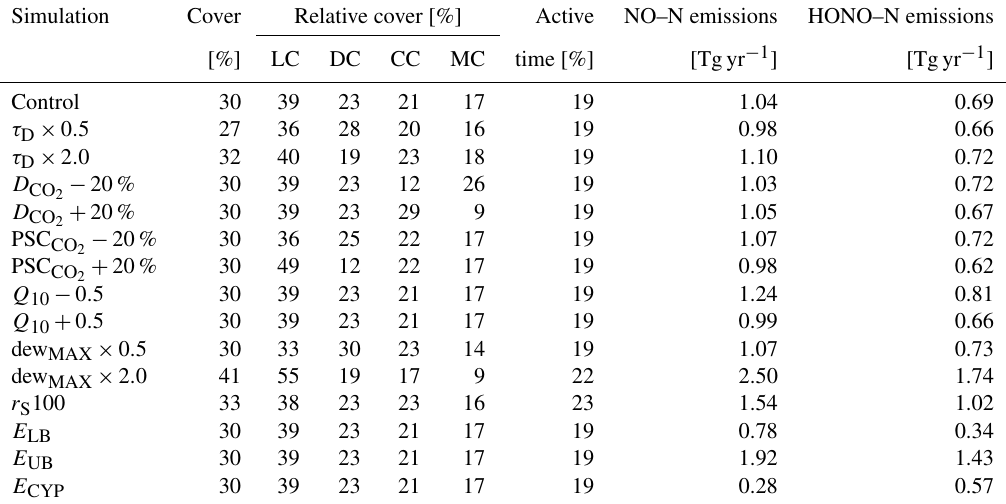
Table 2. Impact of varied parameter values on annual global total values of biocrust cover, relative cover of biocrust types, metabolically active time, and NO and HONO emissions estimated by LiBry. The abbreviations in the second row stand for light cyanobacteria-dominated (LC), dark cyanobacteria-dominated (DC), chlorolichen-dominated (CC), and moss-dominated (MC) biocrusts. “Control” means the control run, which is also shown in Table 1. “ τ D ” denotes the disturbance interval, which is multiplied by 0.5 and 2.0. “ D CO for the value of CO 2 diffusivity and photosynthetic capacity, respectively, which are used to distinguish between crust types. Both parameters are increased and decreased by 20%. “ Q 10 ” represents the temperature dependence of NO and HONO emissions, and it is increased and decreased by a value of 0.5. “dew MAX ” corresponds to the maximum amount of dew per year, which is multiplied by 0.5 and 2.0. “ r S 100” denotes the surface resistance of the vegetation against evaporate, which is increased from 0 to 100sm − 1 . “ E LB ” and “ E UB ” stand for the lower and upper boundaries, respectively, of the relation between water content and NO and HONO emissions. “ E CYP ” corresponds to an alternative relation between water saturation and NO and HONO emissions of biocrust types. Simulation